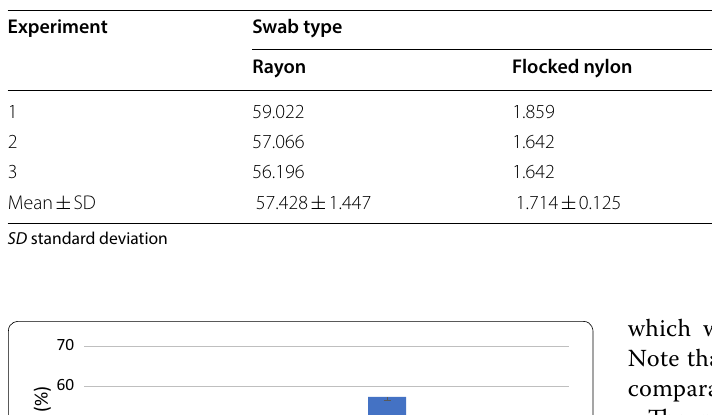
Table 3 Diphtheria toxoid recovery from investigated types of swabs (µg/ml)